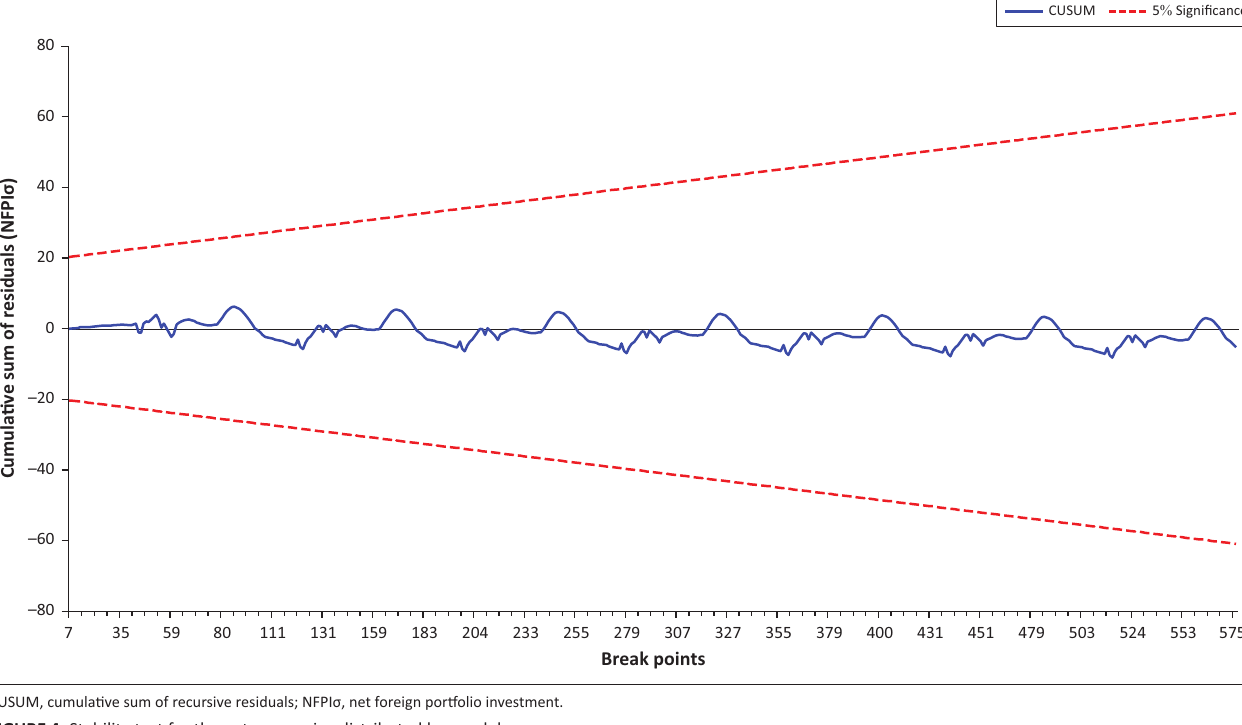
FIG URE 4: Stability test for the autoregressive distributed lag model.